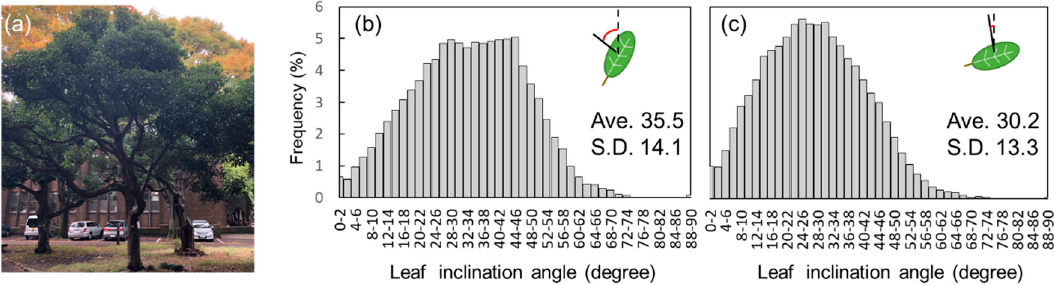
Figure 6. Distribution of leaf inclination angle within a tree (Japanese false oak). Panel ( a ) shows original image. Panels ( b ) and ( c ) show distributions at the top part and lower part, respectively.